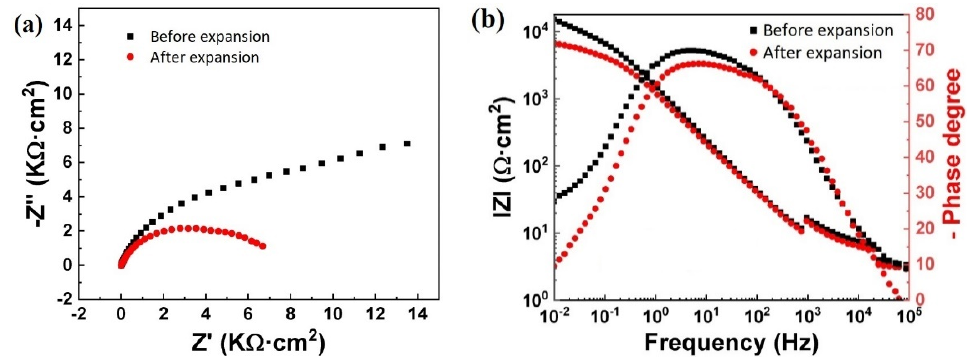
Figure 6. Impedance spectra ( a ) and Bode diagrams ( b ) of AISI 304 SS before and after expansion in the test solution.